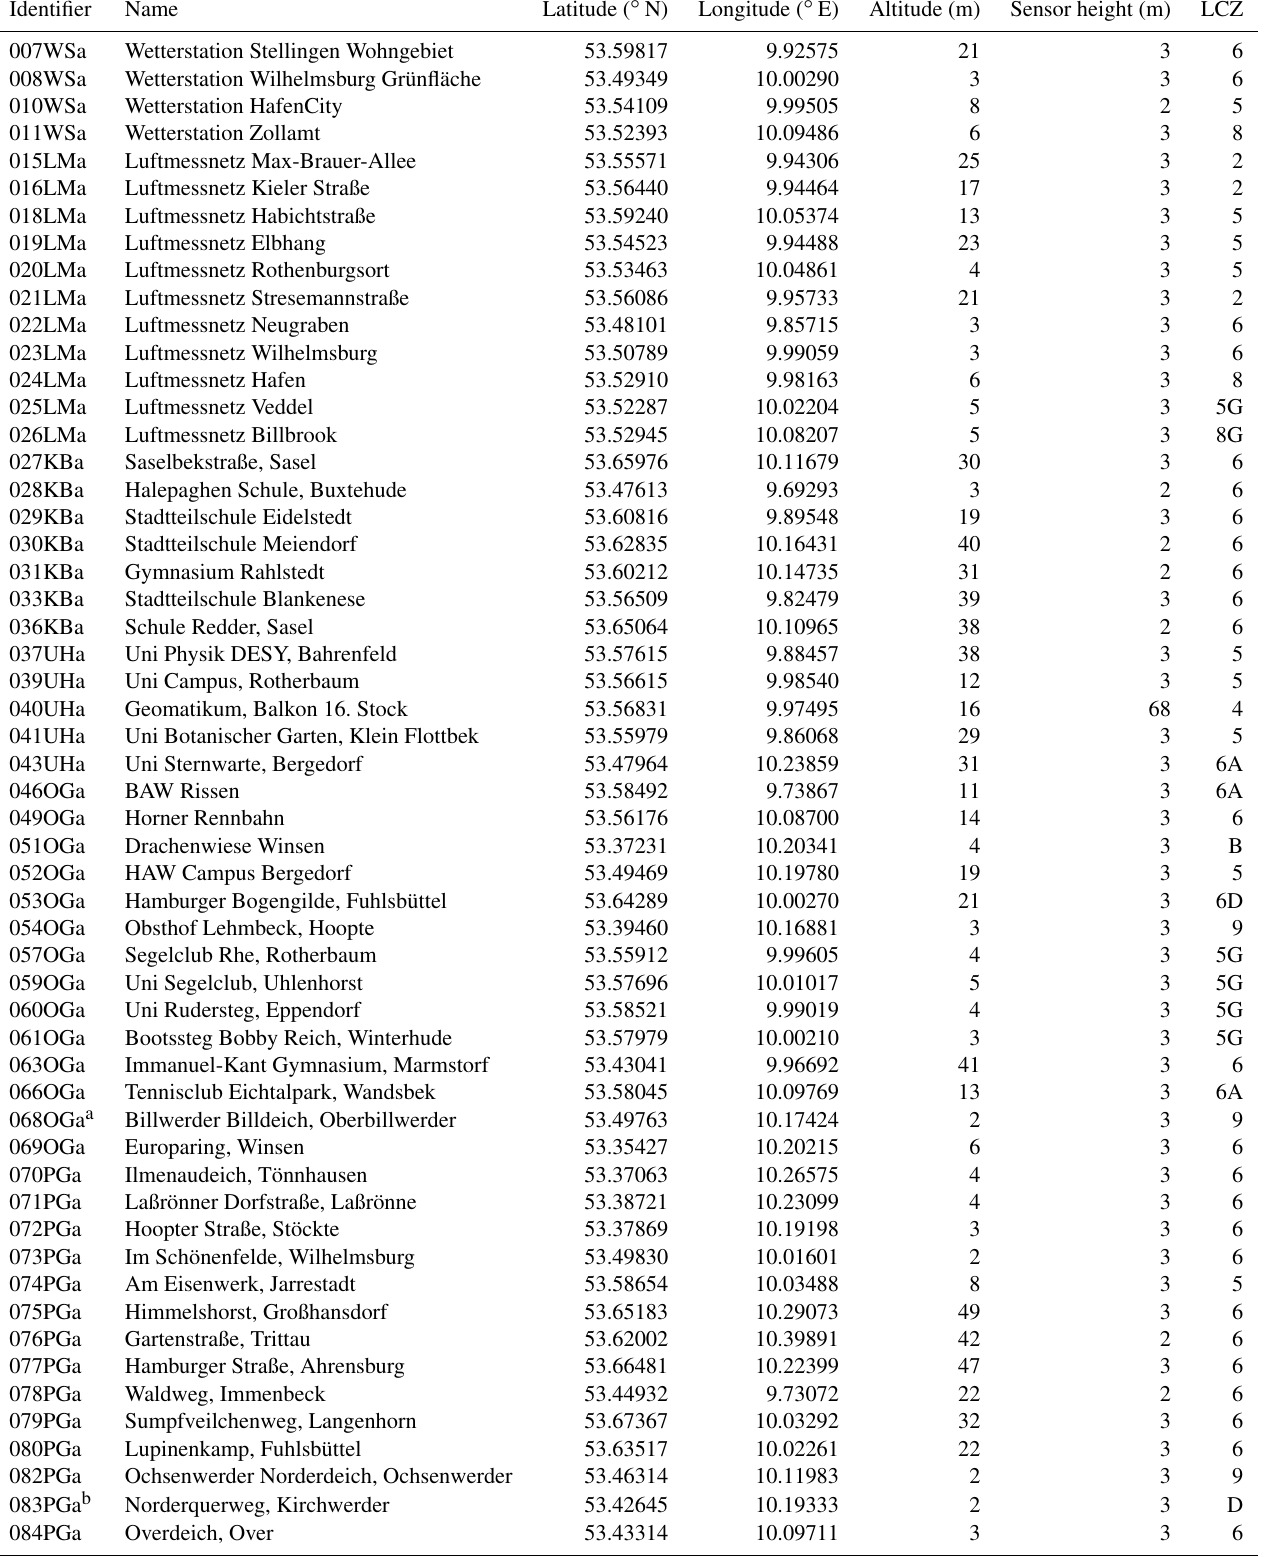
Table 3. Information about APOLLO measurement sites. Altitude denotes the height of ground above sea level, and the sensor height is the height of temperature sensor above ground. See Sect. 3.1 for explanation of local climate zones (LCZs) after Stewart and Oke